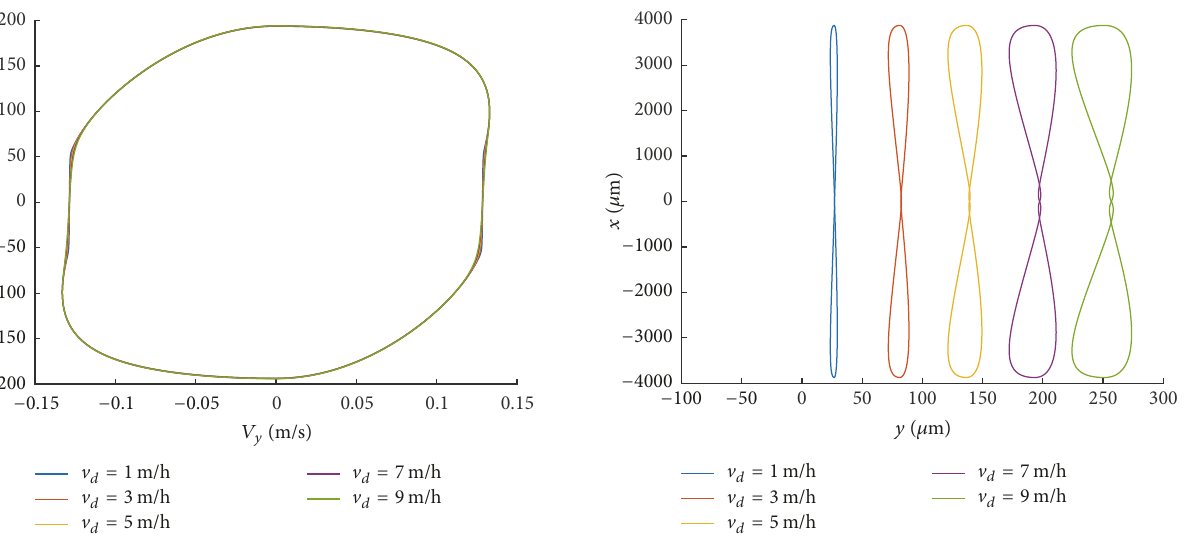
Figure 15: Influence of different amplitudes of torsional oscillation on transverse friction.